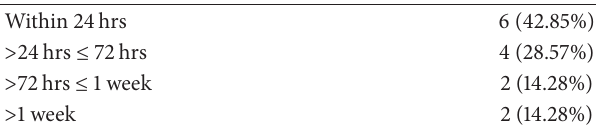
Table 1: Traumatic endophthalmitis-ocular signs.